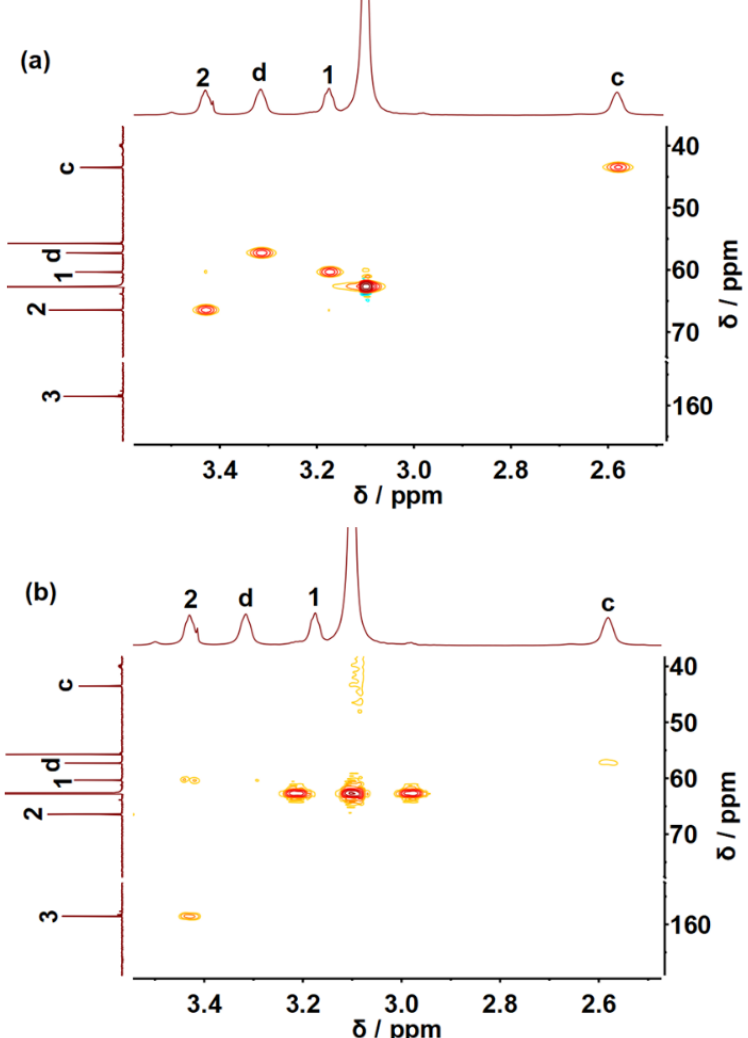
Figure 2. The 2D NMR spectra of TBAE-EG after CO 2 absorption: ( a ) 1 H- 13 C Heteronuclear Single Quantum Coherence ( 1 H- 13 C HSQC); ( b ) 1 H- 13 C Heteronuclear Multiple Bond Correlation ( 1 H- 13 C HMBC).